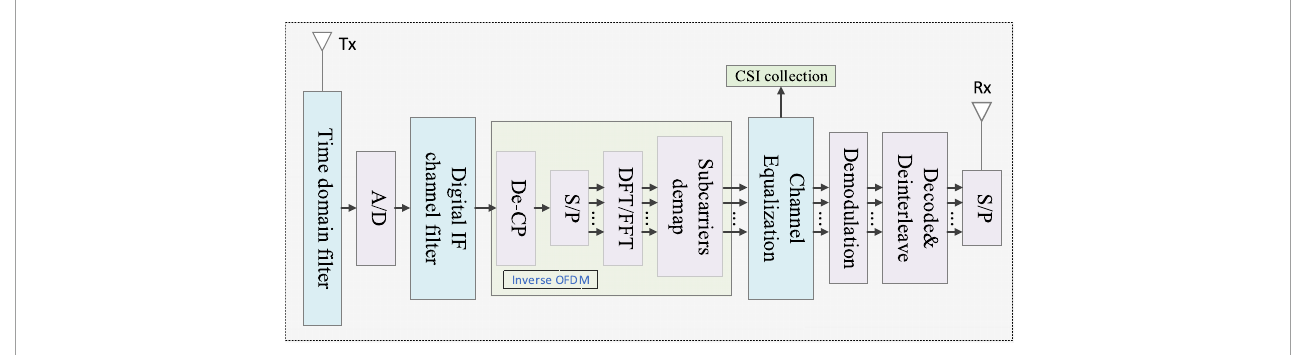
FIGURE2 The specific process of CSI extraction.